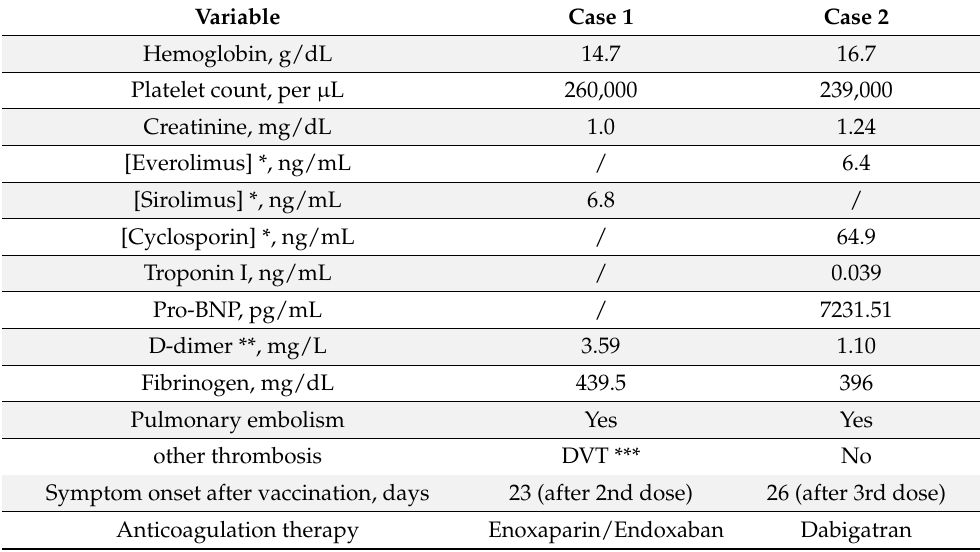
Table 1. Clinical characteristics of each